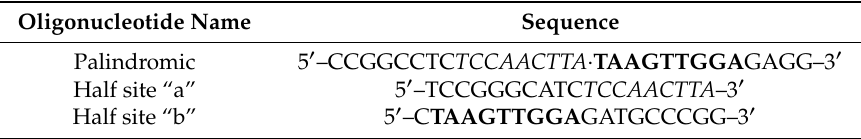
Table 2. Sequences of oligonucleotides derived from UAS1 of the ADH2 glucose-regulated gene and used in DNA binding assays. The sequence recognized by Adr1p wild type is in italics, while its palindrome is in bold. Once in double helix conformation, the first oligo has two binding sites, whereas the second has only one binding site, therefore, it was named the half